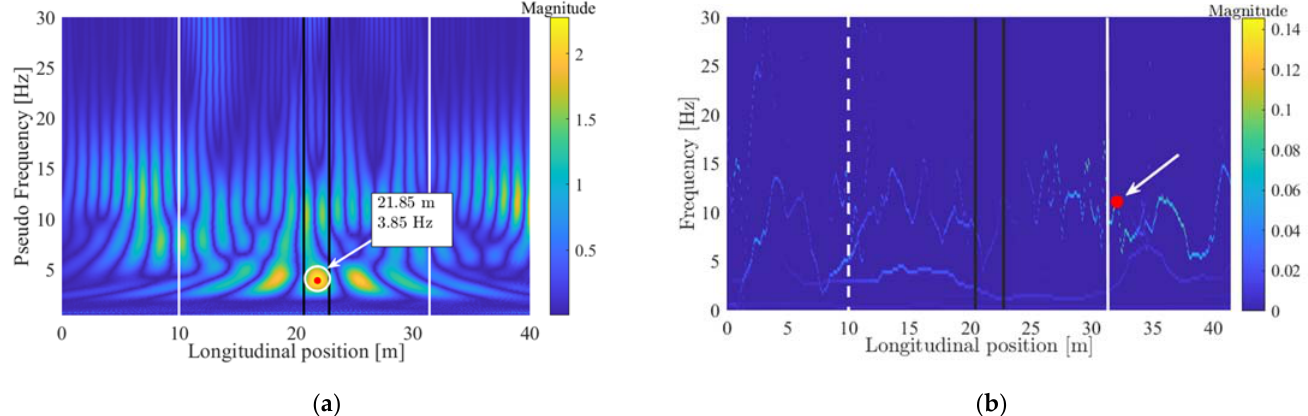
Figure 11. Damage detection results in the presence of different track irregularities in the healthy-bridge and damaged- bridge simulations with the CSA train at 100 km/h and total damage on the fastening between the side wall diagonal element and the lateral chord shown. ( a ) Module of the difference in wavelet coefficients. ( b ) Hilbert spectrum.